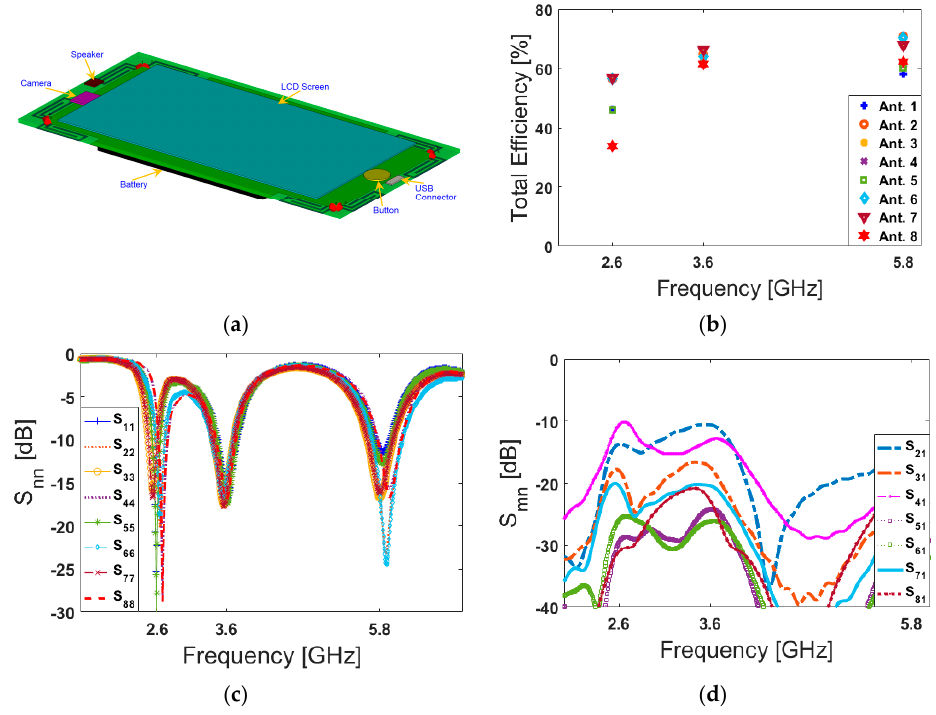
Figure 18. ( a ) Placement, ( b ) total efficiencies, ( c ) S nn , and ( d ) S mn results in the presence of the smartphone components. smartphone